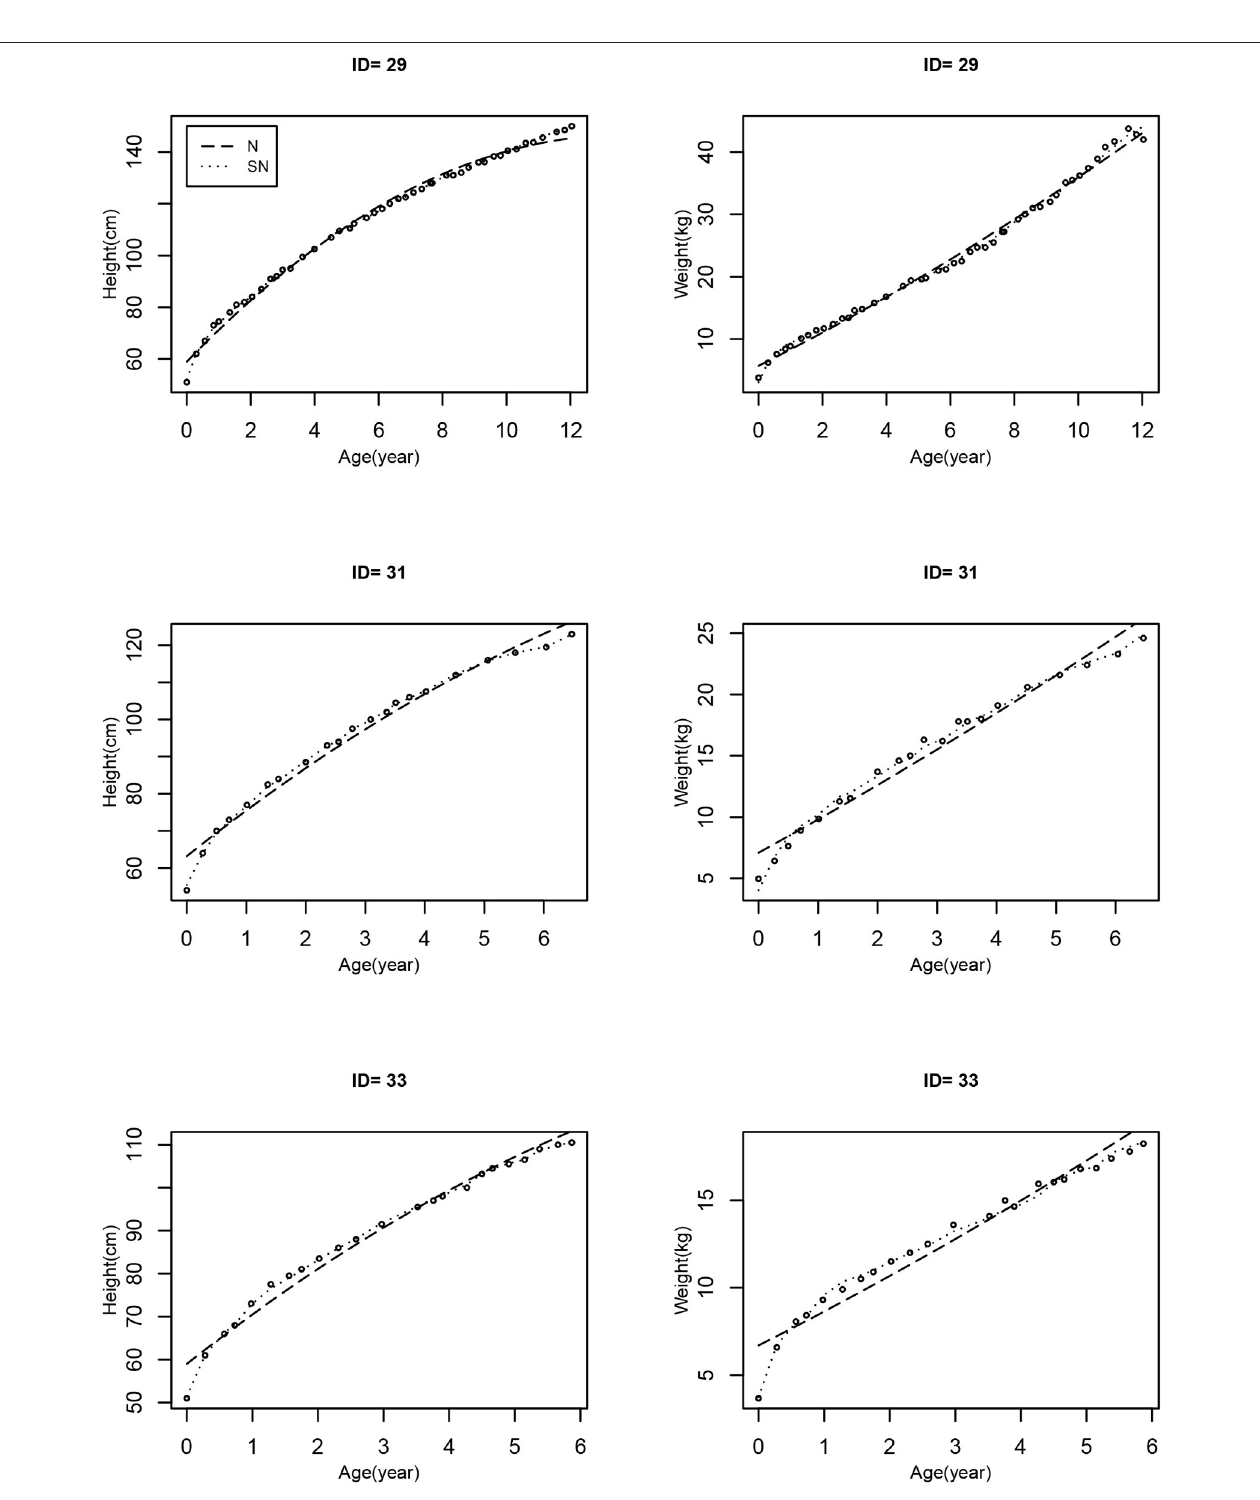
FIGURE 3 | The individual estimates of height and weight trajectories for 3 randomly selected patients based on the two models (Model N: dashed line; Model SN: dotted line). The observed values are indicated by circles.